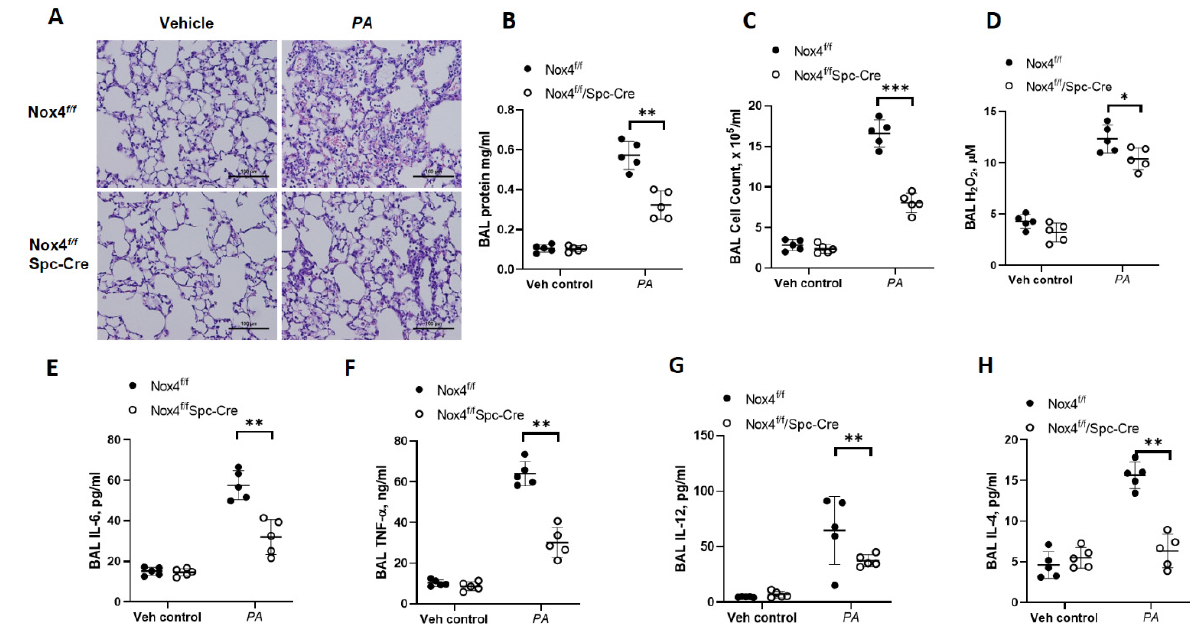
Figure 1. Deletion of NADPH Oxidase 4 (NOX4) in alveolar type II cells of mice reduced P. aeruginosa -induced lung inflammatory injury. Nox4 flox/flox and LEp-Nox4 knock out (KO) mice were challenged intratracheally with sterile PBS or P. aeruginosa ( PA ) (1 × 10 6 CFU/mouse) for 24 h. Lungs were lavaged, bronchoalveolar lavage (BAL) fluid collected, formalin fixed, embedded in paraffin, and cut into 5 μ m sections for Hematoxylin-Eosin (H&E) staining. ( A ) Representative H&E staining photomicrograph of lung section from Nox4 flox/flox , LEp-Nox4 KO mice with/without PA challenge, original magnification ×20. Scale bar = 100 μ m. ( B – H ) BAL fluids from control and PA -challenged Nox4 flox/flox , LEp-Nox4 KO mice were analyzed for protein ( B ), infiltrating cells ( C ), Hydrogen peroxide (H 2 O 2 ) levels ( D ), and pro-inflammatory cytokines ( E – H ). Data are expressed as means ± SD from one experiment (number of animals per group = 5). * p < 0.05, ** p < 0.01, *** p < 0.005.